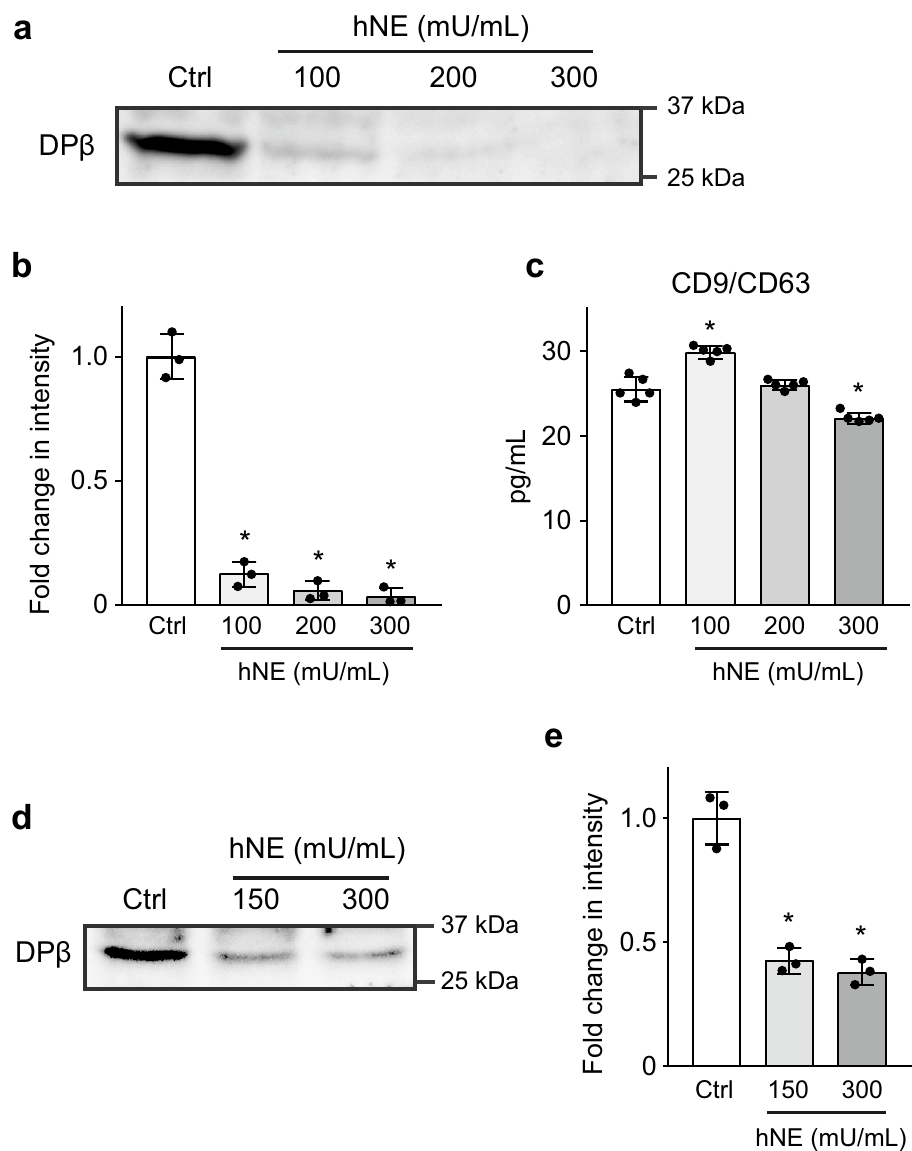
Figure 4. Neutrophil elastase (NE) degrades HLA class II on extracellular vesicles derived from macrophages. ( a ) THP-1-derived macrophages were cultured in RPMI 1640 in the presence or absence of various concentrations of hNE (100–300 mU/mL) for 6 h. HLA-DP β1 expression on extracellular vesicles isolated from supernatant samples was determined by Western blot analysis. ( b ) Intensity of Western blotting signals of HLA-DP β1 on extracellular vesicles isolated from supernatant samples was quantified by densitometry. Data represent the means ± SD of triplicate experiments and were evaluated by one-way analysis of variance with Dunnett’s multiple-comparisons test. *Significantly different as compared with that of the control group at P < 0.01. ( c ) Extracellular vesicle production in supernatant samples were measured with a CD9/CD63 ELISA kit. Data represent the mean ± SD of quintuplicate experiments and were evaluated by one-way analysis of variance with Dunnett’s multiple-comparison test. *Significantly different from control group at P < 0.01. ( d ) Extracellular vesicles were isolated from supernatant of THP-1 derived macrophages followed by hNE-treatment (150 and 300 mU/mL) for 4 h. Western blot analysis was performed to determine HLA-DP β1 expression in NE-treated and untreated extracellular vesicles. ( e ) Intensity of Western blotting signals of HLA-DP β1 on hNE-treated extracellular vesicles was quantified by densitometry. Data represent the means ± SD of triplicate experiments and were evaluated by one-way analysis of variance with Dunnett’s multiple-comparisons test. *Significantly different as compared with that of the control group at P <